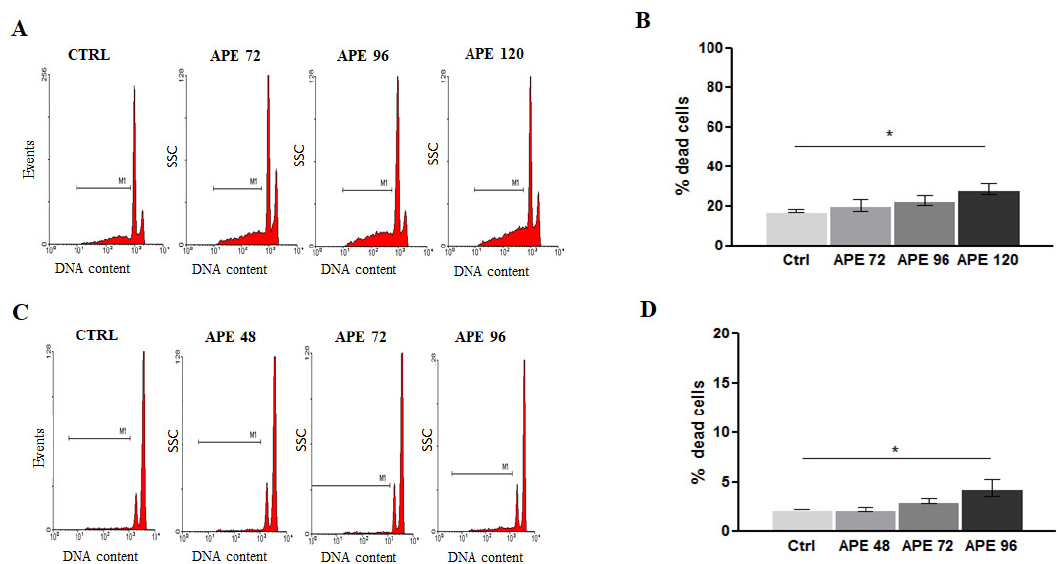
Figure 6. ( A ) Cytometric analysis of dead cells in GB8 cell cultures after 100 μM APE treatment. ( B ) Percentage of apoptotic cells present in GB8 cultures after 100 μM APE treatment. ( C ). Cytometric analysis of apoptosis in GB7 cells after APE treatment. ( D ) Percentage of apoptotic cells present in GB7 cultures after 100 μM APE treatment. (ANOVA test; * p < 0.05). The data are the average ±SEM of three independent experiments.